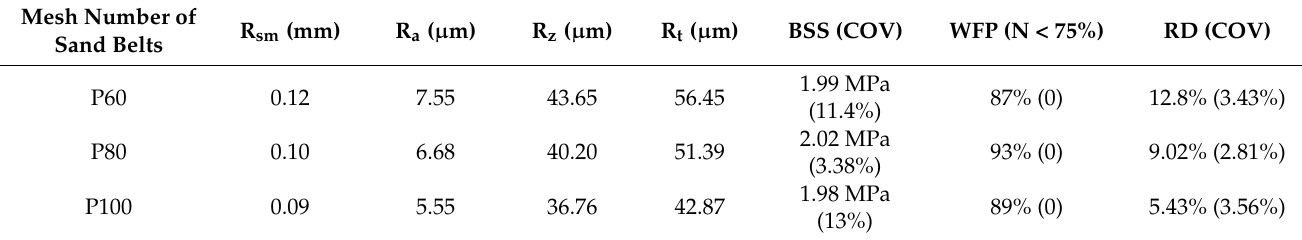
Table 4. Surface roughness of specimens prepared with different sanding belts and its effects on BSS and RD. Mesh Number of Sand